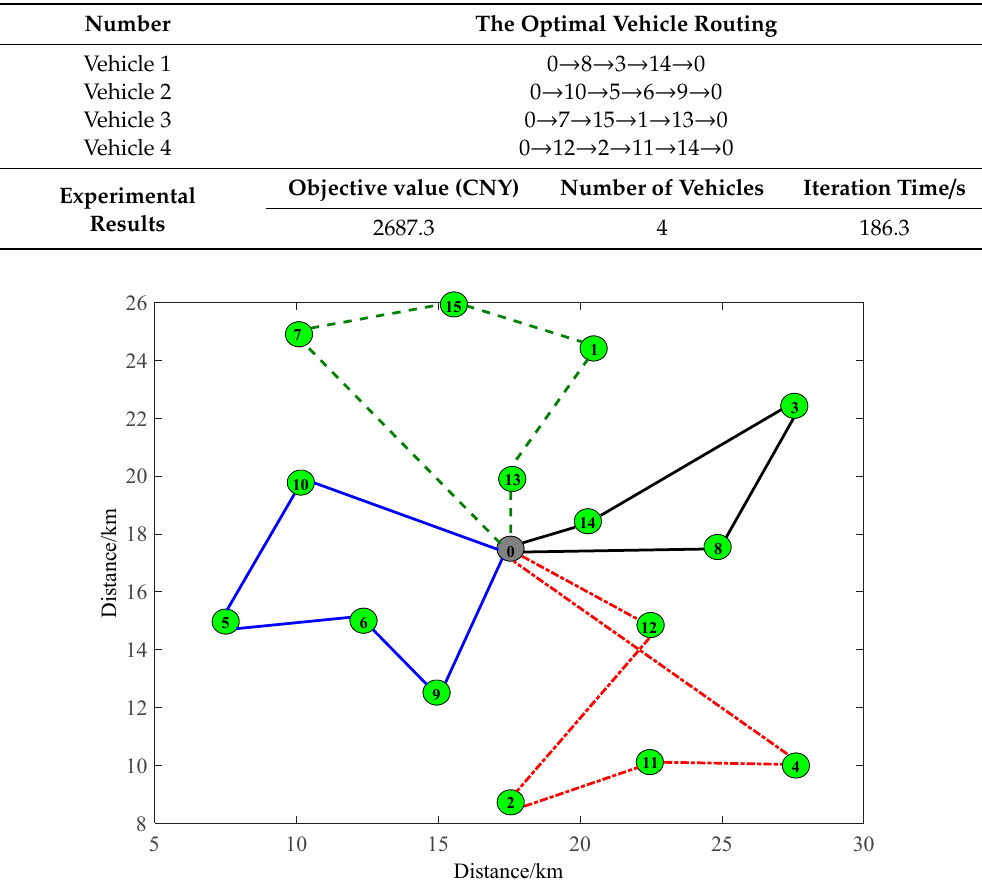
Table 2. Optimal results of GAAO.